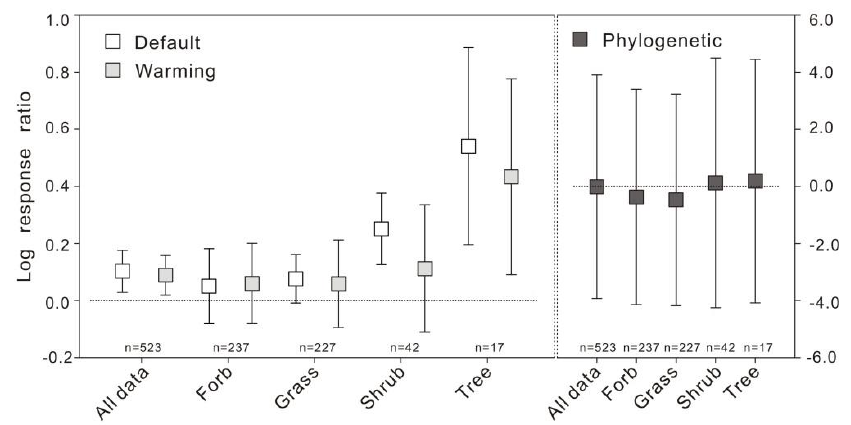
Figure 5. Responses of above-ground biomass (AGB) to warming as mean effect sizes ±95% CI across plant functional types (PFTs). The numbers ( n ) of observations are shown near the bar. Default: mean effect sizes weighted by inverse-variance (traditional meta-analysis); Warming: mean effect sizes weighted by Delta T and Warm D (Equation (4)); Phylogenetic: plant phylogenetic feature was included in the model.